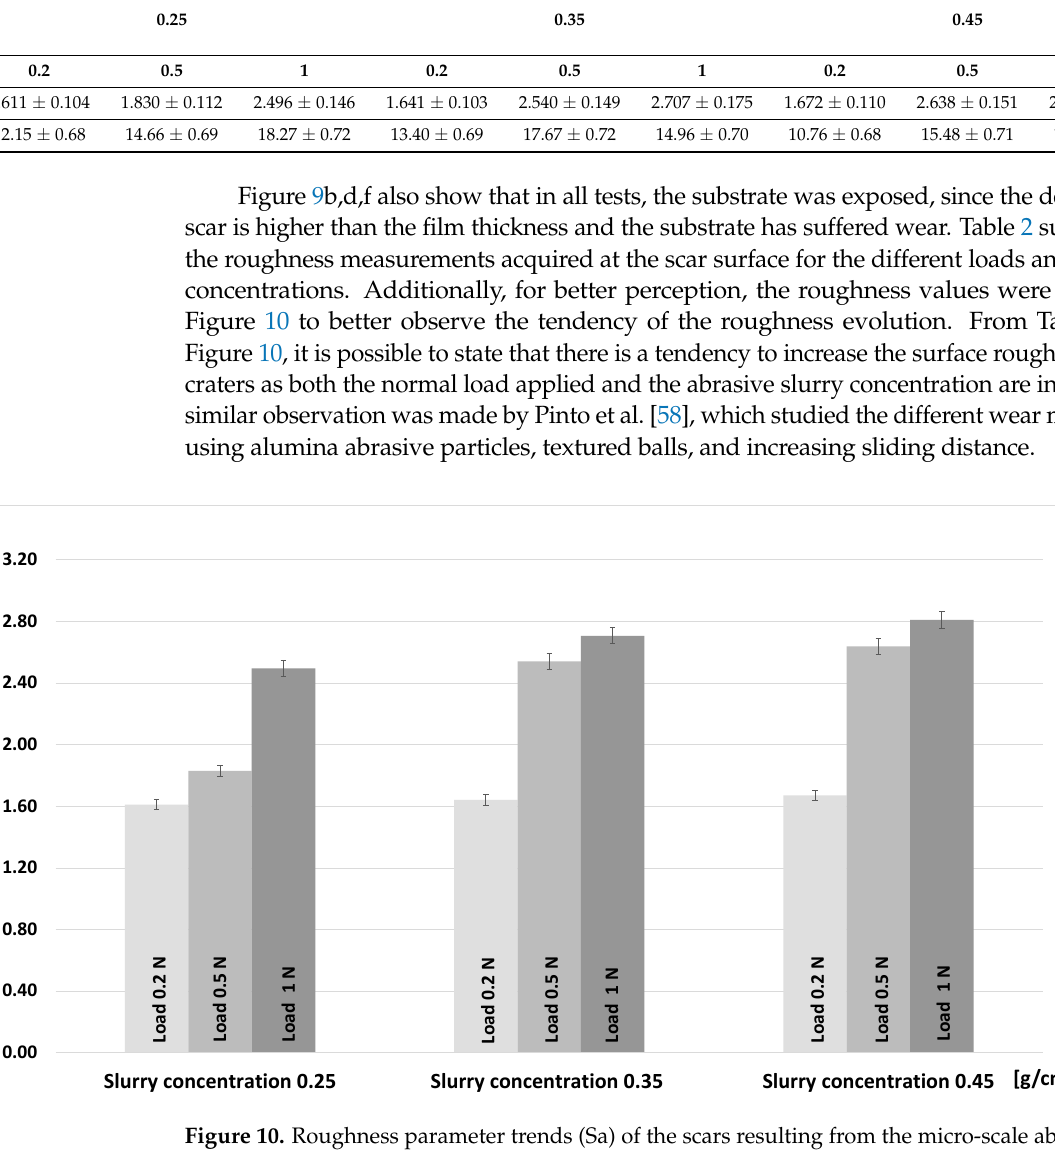
Table 2. Results obtained from the amplitude parameters (Sa and Sz) in the height deviation of the topography of the craters. Surface texture ISO 25178; Height parameters ( µ m).